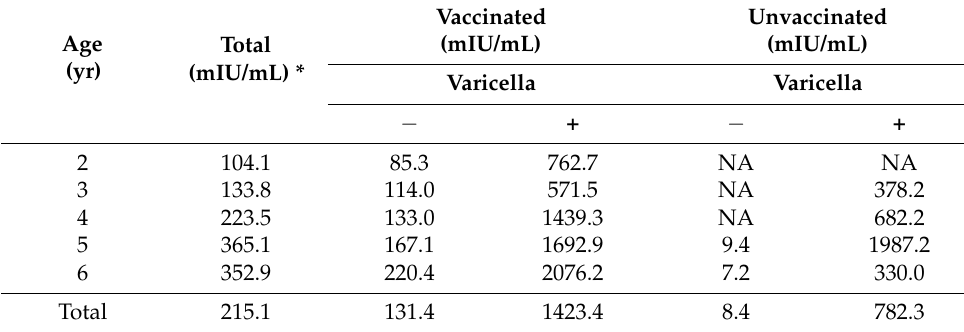
Table 5. gpEIA GMT based on vaccination and varicella histories in 2- to 6-year-old children.